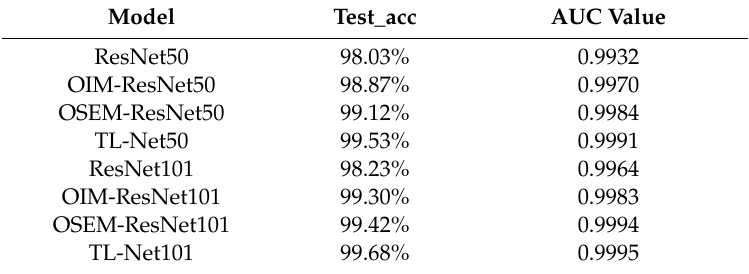
Table 2. The accuracy of ResNets with each optimized module. “OIM-ResNet” denotes the ResNet with the OIM. “OSEM-ResNet” denotes the ResNet with the OSEM. ”Test_acc” denotes the accuracy on the test data.